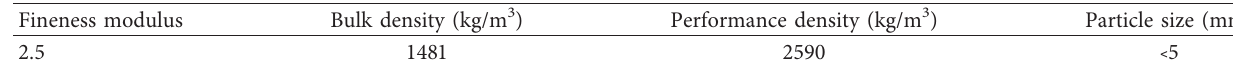
Table 3: Properties of fine aggregates.